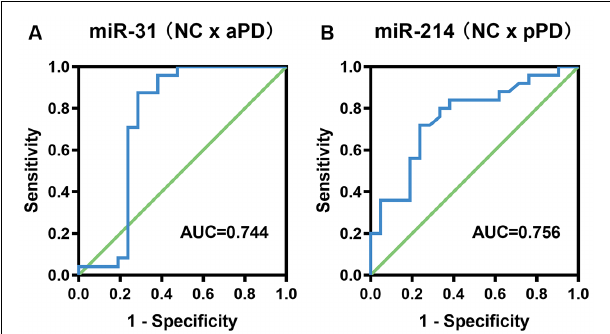
FIGURE 2 | ROC curve analysis for the diagnosis of aPD (A) , pPD (B) . aPD, advanced Parkinson’s disease, pPD, prodromal Parkinson’s